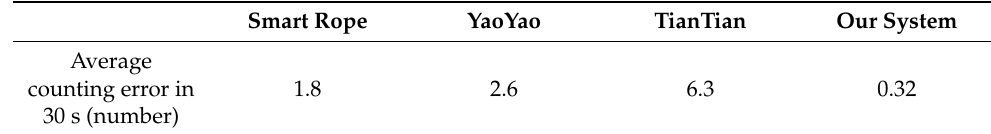
Table 2. Results of the average counting errors for different